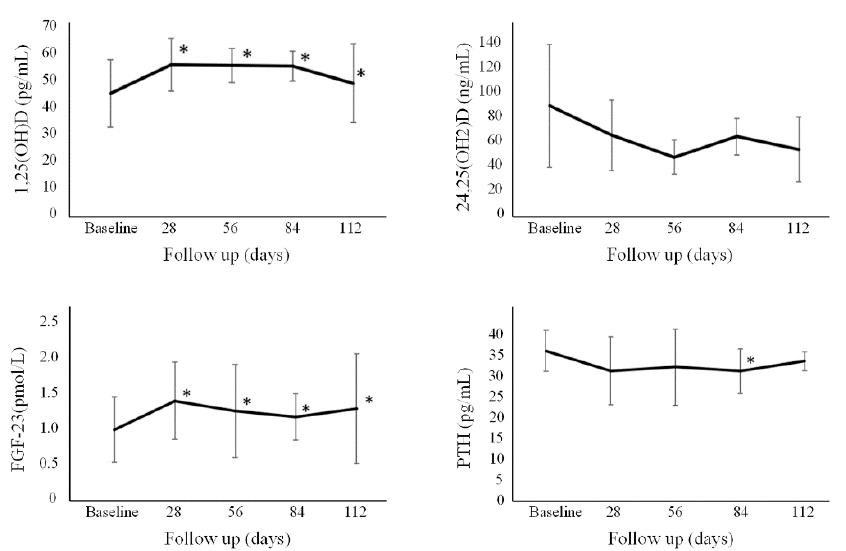
Figure 2. Absolute changes of the overall cohort of 1,25OH2D, 24,25OH2D, PTH, and FGF-23. * p < 0.05 with respect to baseline. Error bars denote standard deviation. FGF-23 = fibroblast growth factor-23; PTH = parathyroid hormone.